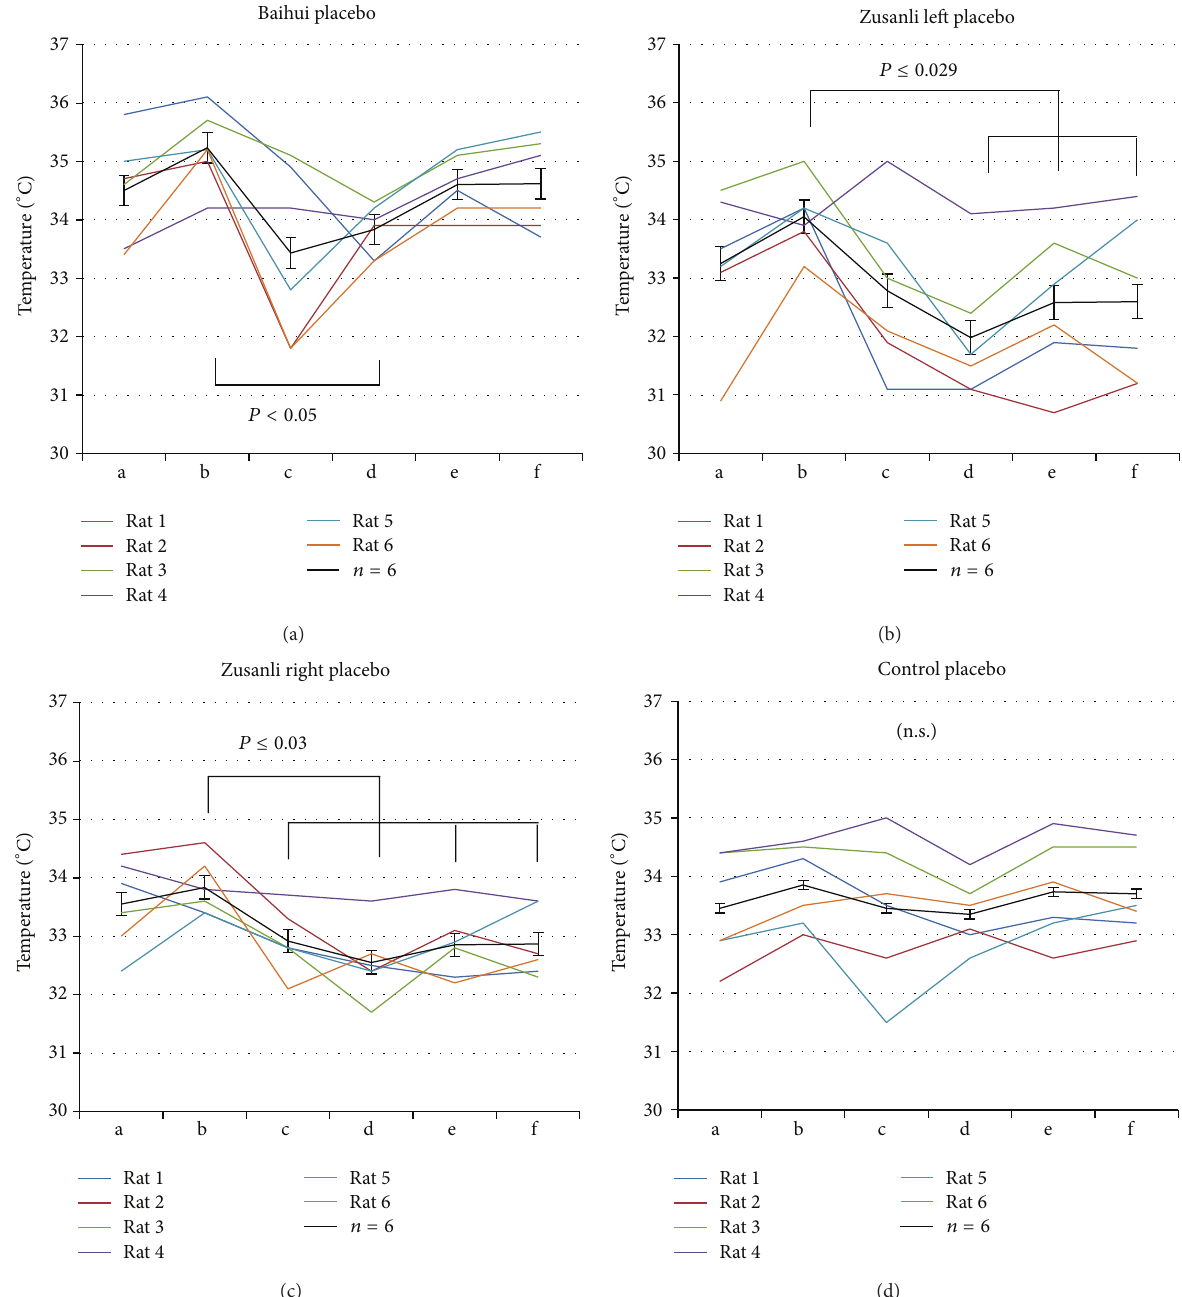
Figure 9: Temperature values of all rats during the different phases (a–f, see Figure 4) of placebo stimulation.